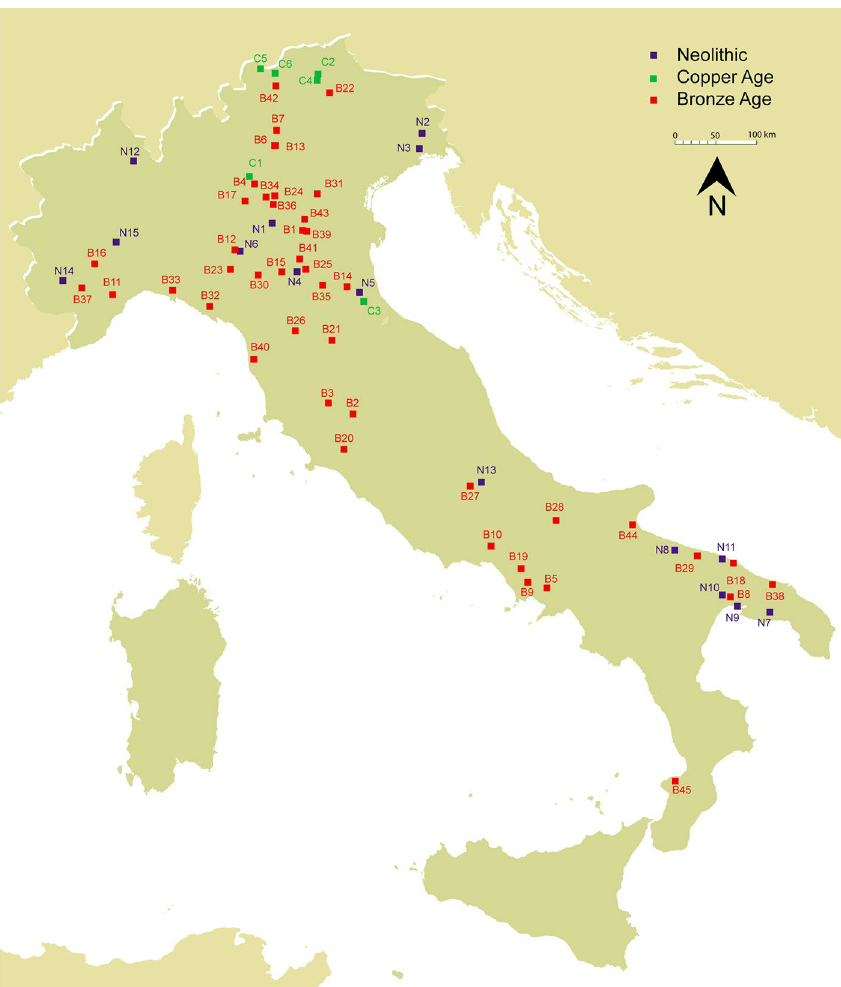
Figure 5. Map of Neolithic, Eneolithic and Bronze Age sites where archeobotanical remains of common and foxtail millet have been found (the list of the sites and the relative references are in Supplementary Information 2, Table